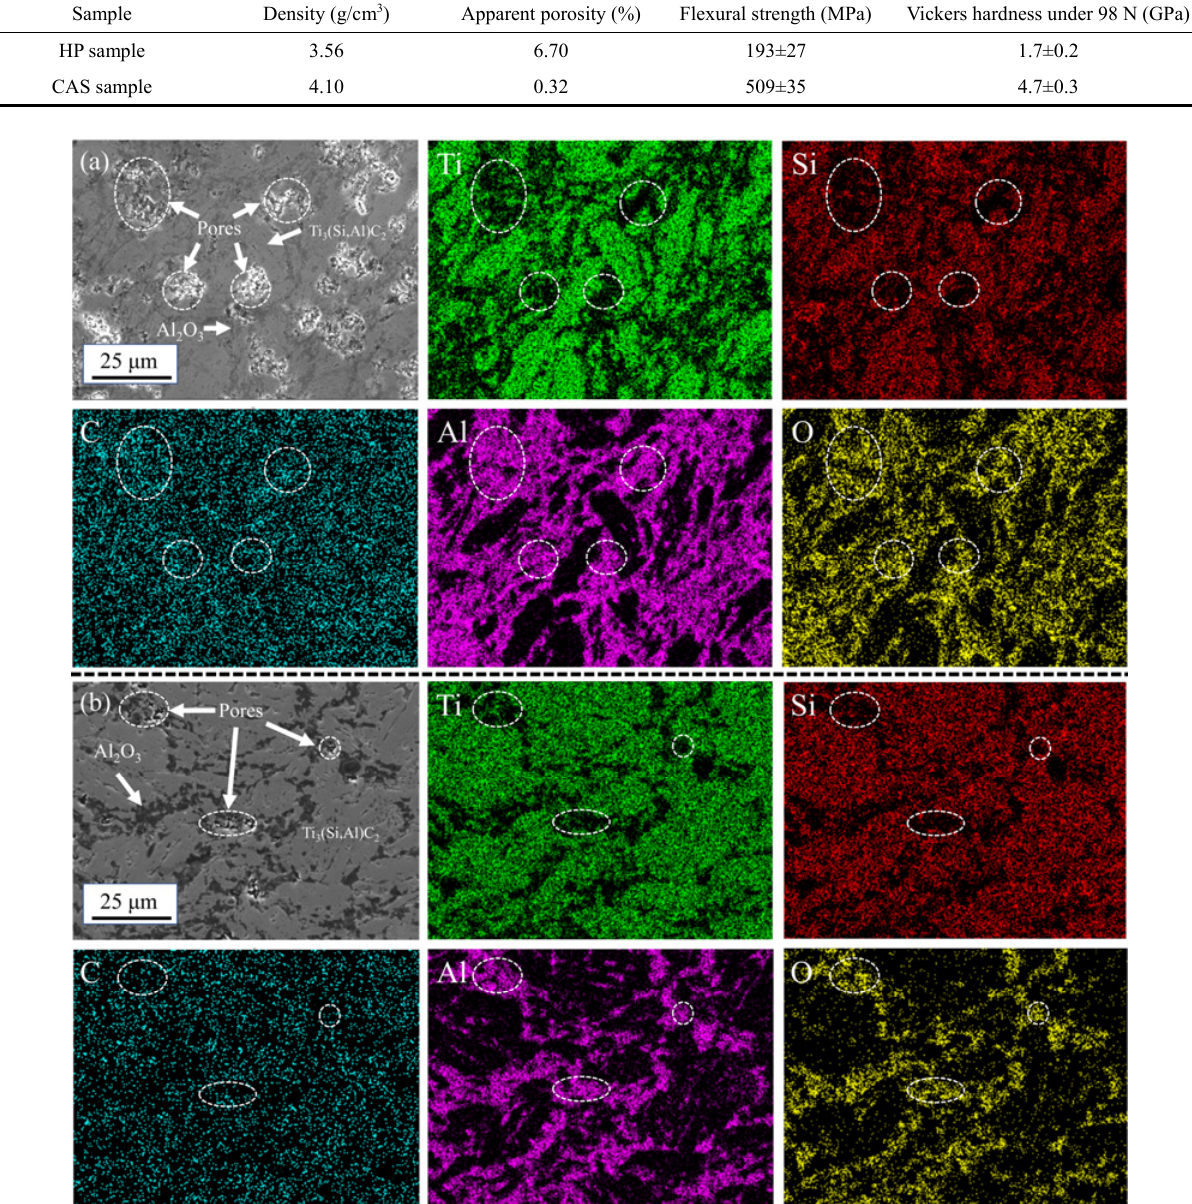
Fig. 2 (a) Micrographs of the polished surfaces of the HP sample with corresponding elemental distributions and (b) micrographs of the polished CAS sample surfaces with corresponding elemental